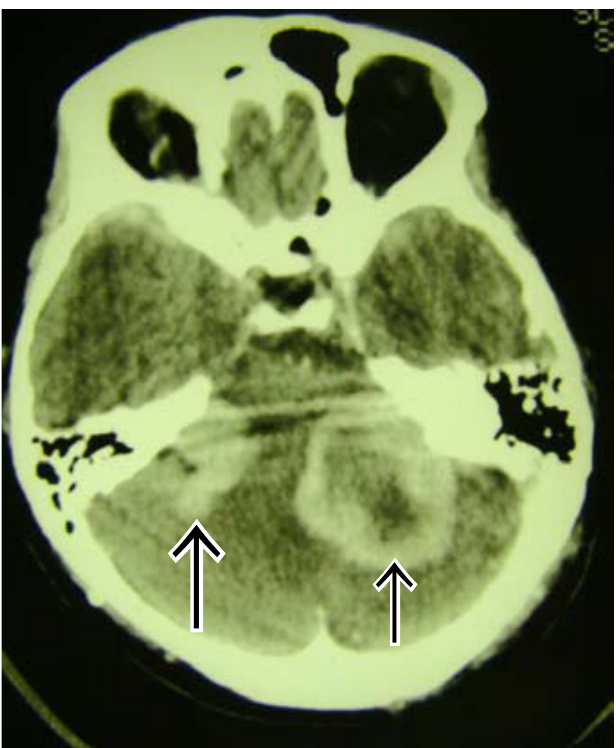
Fig. 19c. Axial contrast-enhanced brain CT at multiple levels with multiple meningiomas and bilateral acoustic neuromas.